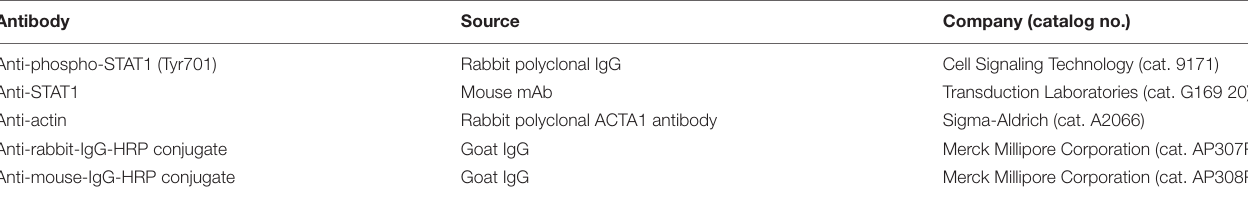
TABLE 1 | Antibodies used for Western Blot analysis.